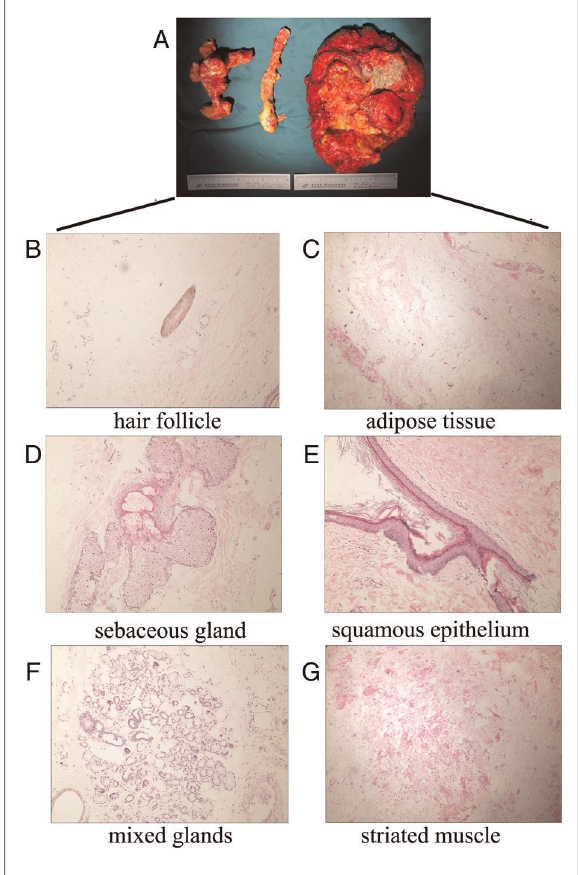
FIGURE 3 The gross appearance and pathological examination of the teratoma. ( A ) The teratoma measured 24×23×15 cm and weighed 5 kg. Two intact bones were isolated from the mass: one was 11 cm long with a diameter of 3 cm, and the other was irregular (6×6×5 cm). The two bones formed a pseudoarthrosis. ( B – G ) Pathological slides stained with hematoxylin and eosin: (B ) hair follicle, ( C ) adipose tissue, ( D ) sebaceous gland, ( E ) squamous epithelium, ( F ) mixed glands, and ( G ) striated muscle.